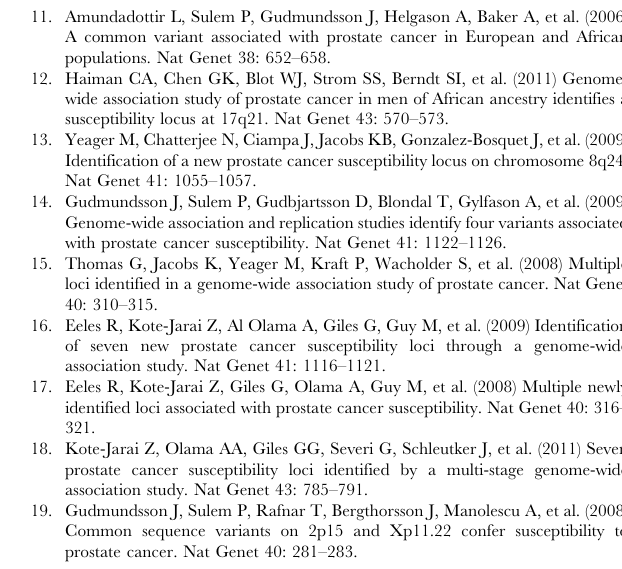
Table S1 Summary results of the previously reported SNPs associated with prostate cancer susceptibility in GWAS of the Japanese. Table S2 The results of association study for rs620861. Figure S1 Reproducibility of the model in MEC Japa- nese samples. ROC curves of the risk prediction model in a set of Japanese samples from the Multiethnic Cohort in Hawaii and California ( MEC ). Right panel shows the ROC curve when all the samples were used. Left panel shows the ROC curve for the samples with PSA 1–10 ng/ml (only the samples whose serum PSA levels were known before genotyping are included). The AUCs of the model and 95% confidence intervals are indicated. Figure S2 Distribution of odds ratio estimated from the prediction model. (A) Distribution of odds ratio in all the case and control samples used for analysis in the present study. Odds ratio at each percentile of population is described. (B) Distribution of odds ratio in case (red) and control (blue) samples are plotted. The difference in odds ratio between case and controls are statistically compared by Student’s t -test, and the P -value is reported.